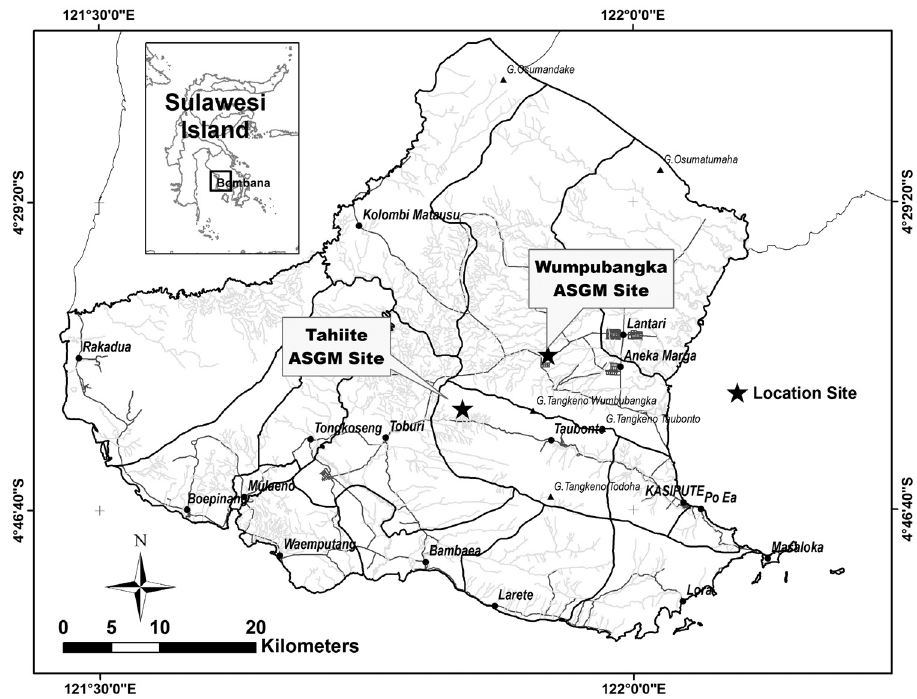
Figure 1. Map of Bombana regency displays the study area. The Tahi Ite and Wumpubangka spots represent the artisanal and small-scale gold mining sites.